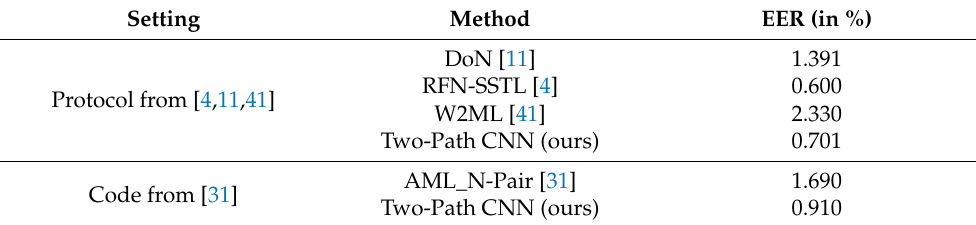
Table 4. Comparison against state-of-the-art methods from the literature. The comparison is done on the IITD dataset in terms of EER values. All results are presented in (%).